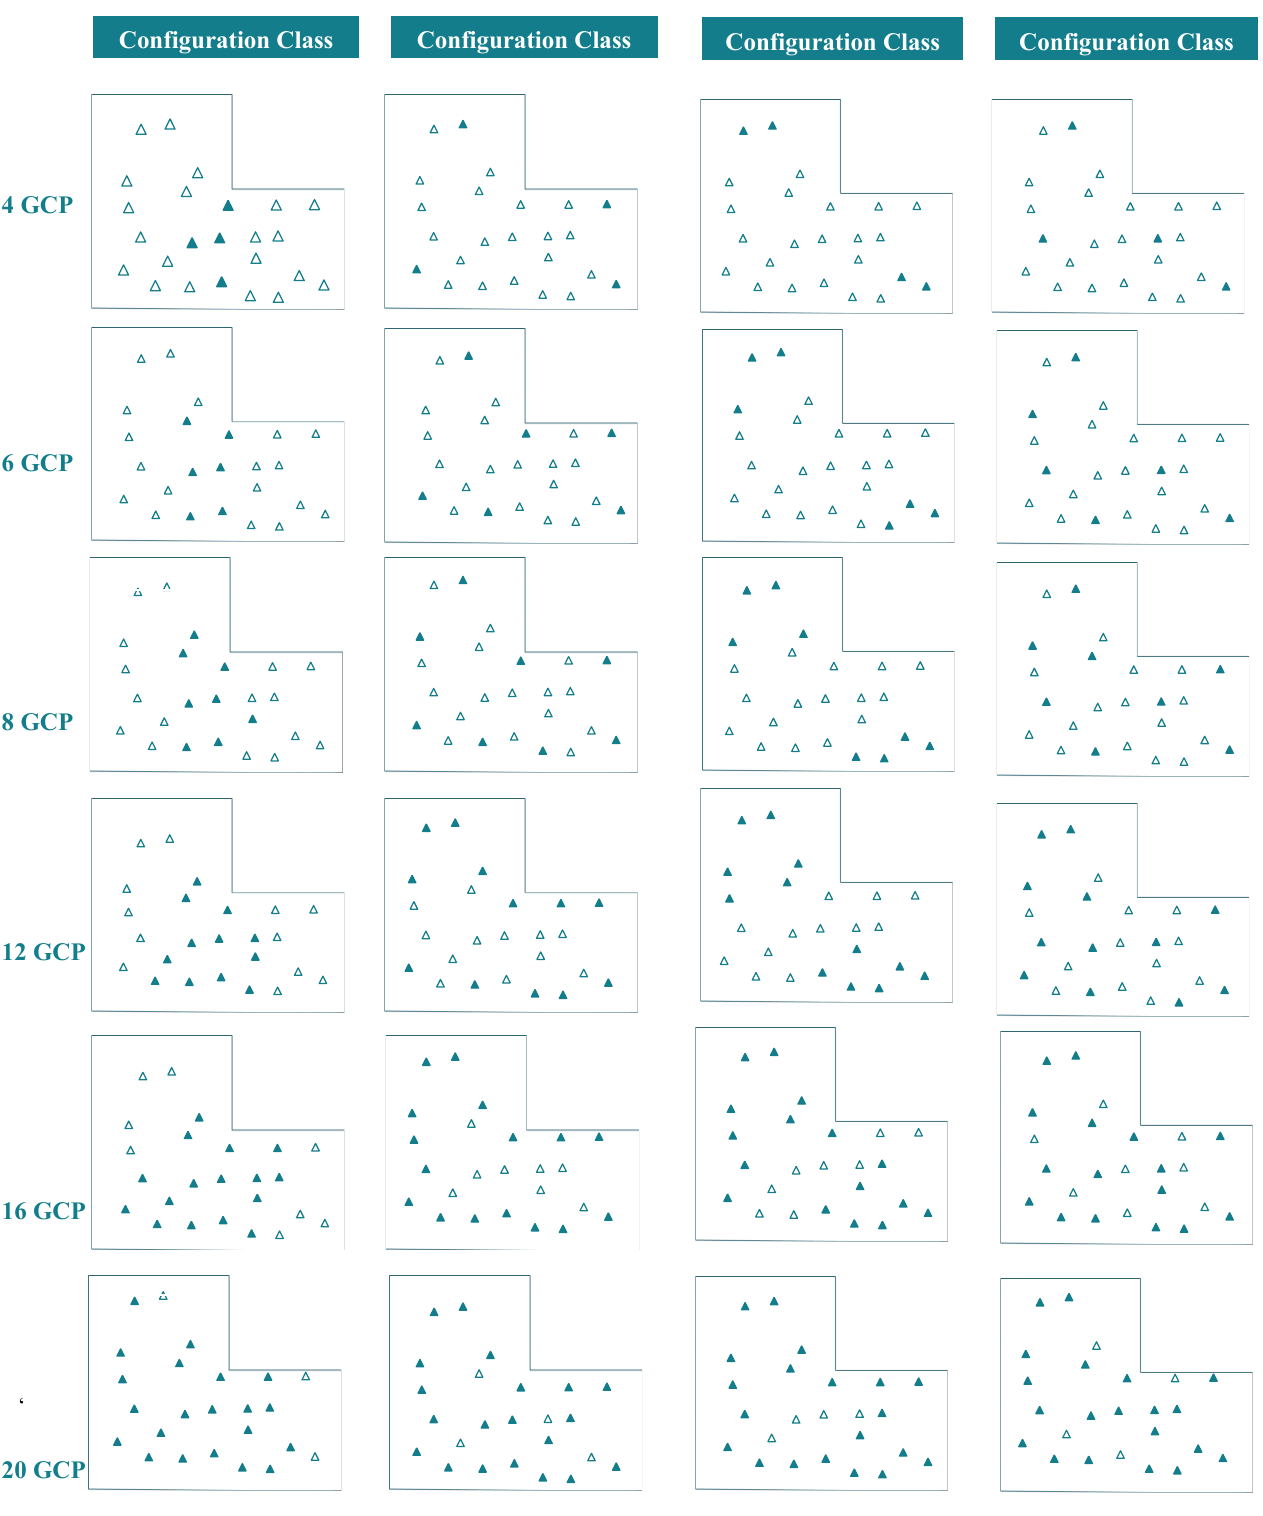
Figure 3. Configuration classes defined for distribution test. The empty triangles denote the checkpoints while the shaded triangles represent the points used for ground